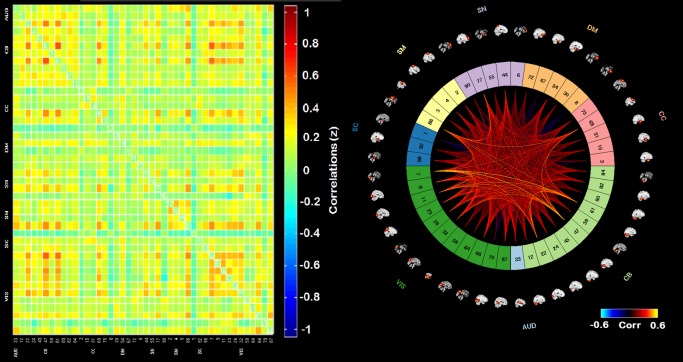
Adjacency matrix and connectogram highlighting the connectivities across subnetworks for state 6.Abbreviations: Aud: auditory network, ECN: executive control network, DMN: default mode network, SM: sensory-motor network, SN: salience network.